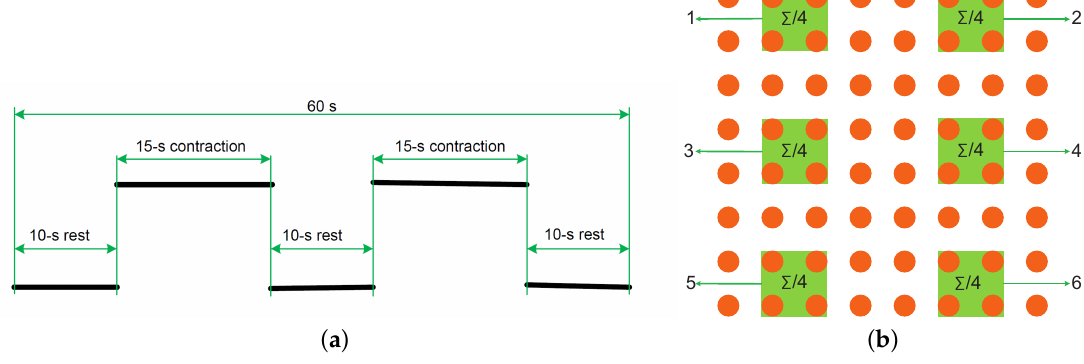
Figure 1. ( a ) Scheme of the measurement protocol. ( b ) Six subsets of electrodes employed to generate six electromyogram (EMG)